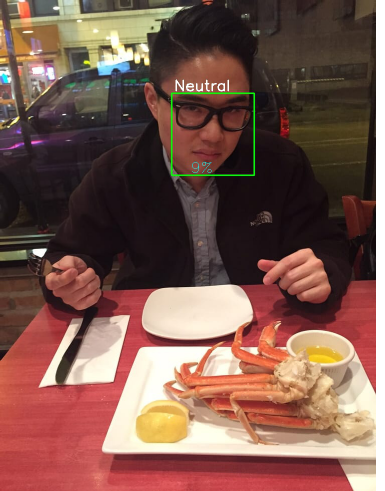
Fig.10. Image identified as a neutral image